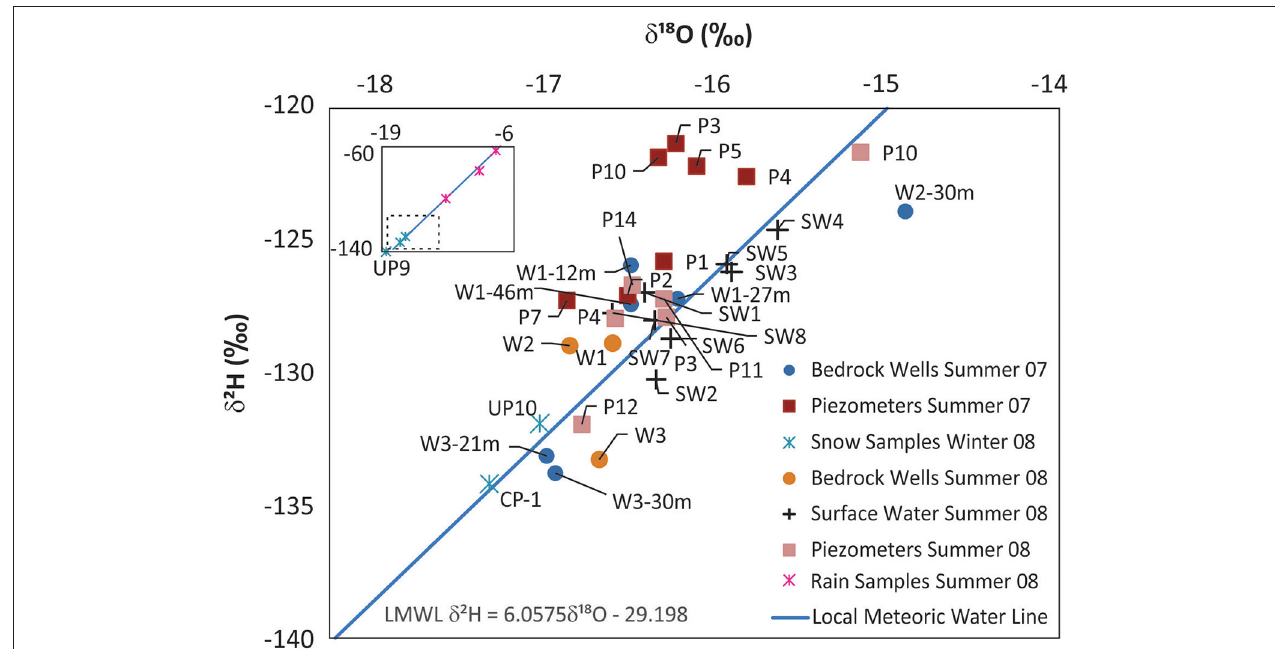
FIGURE 9 | Plot showing δ 18 O versus δ 2 H for water samples collected at UPC241. The local meteoric water line (LMWL) was constructed from all snow and rain samples (shown in the inset plot; the main plot area is shown as a dashed rectangle on the inset